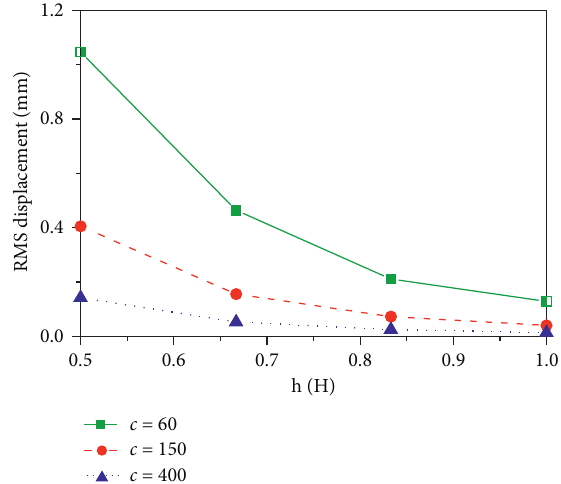
Figure 7: The relationship between the root mean square of structural displacement response and the installation height of damping cable h / H .